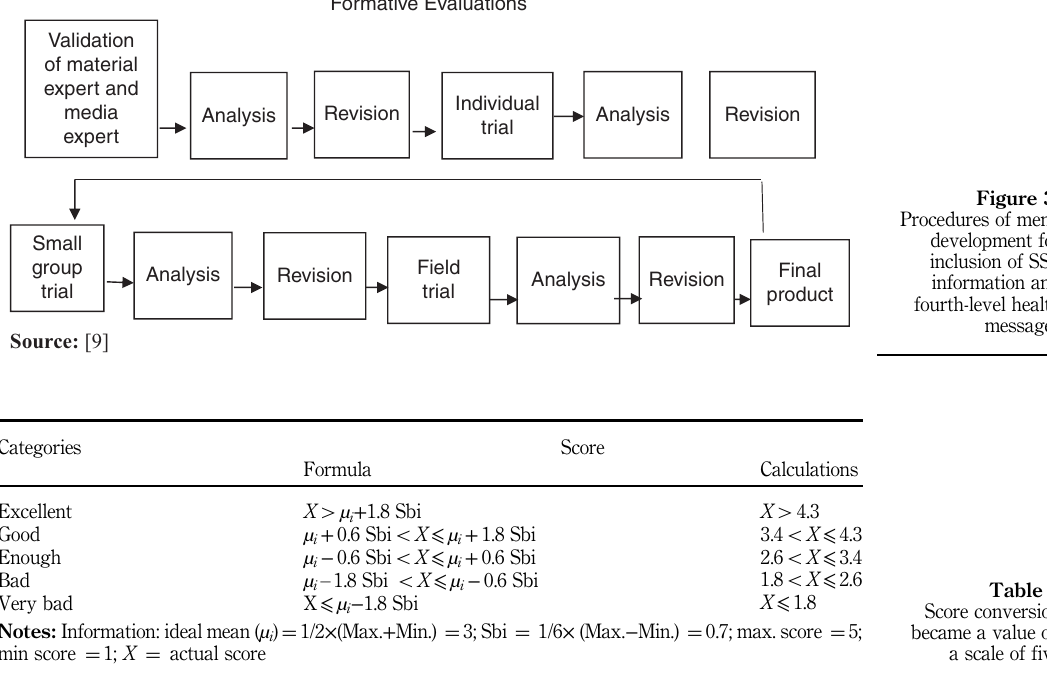
Figure 3. Procedures of